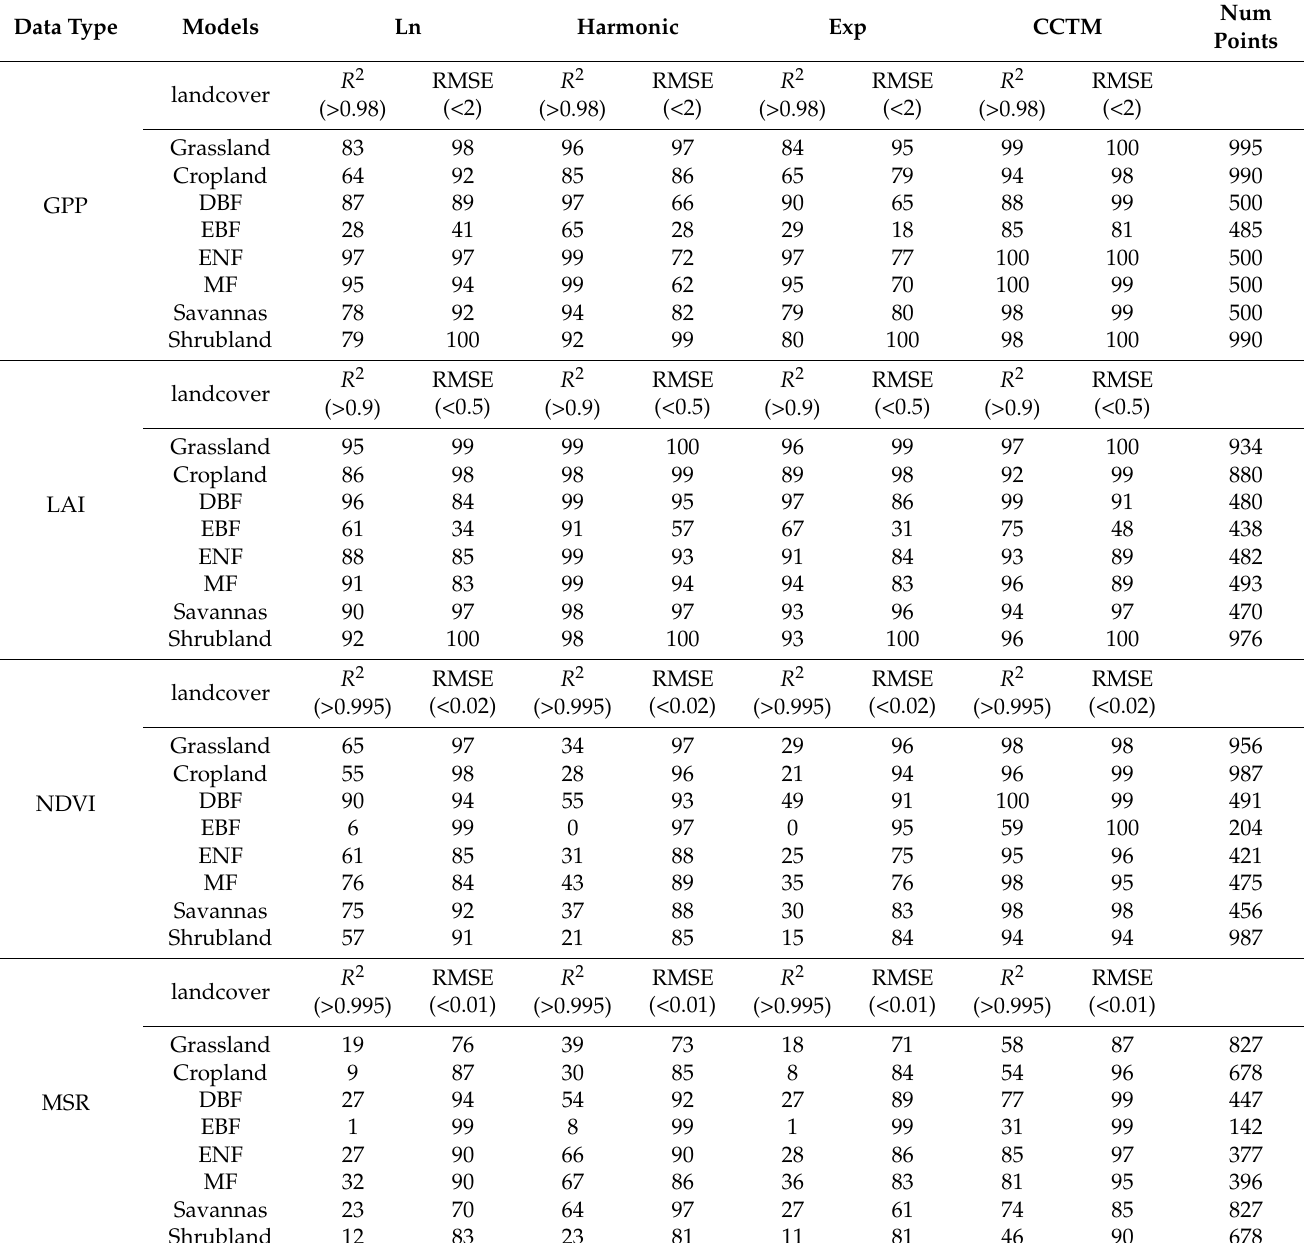
Table 3. Reconstruction results after